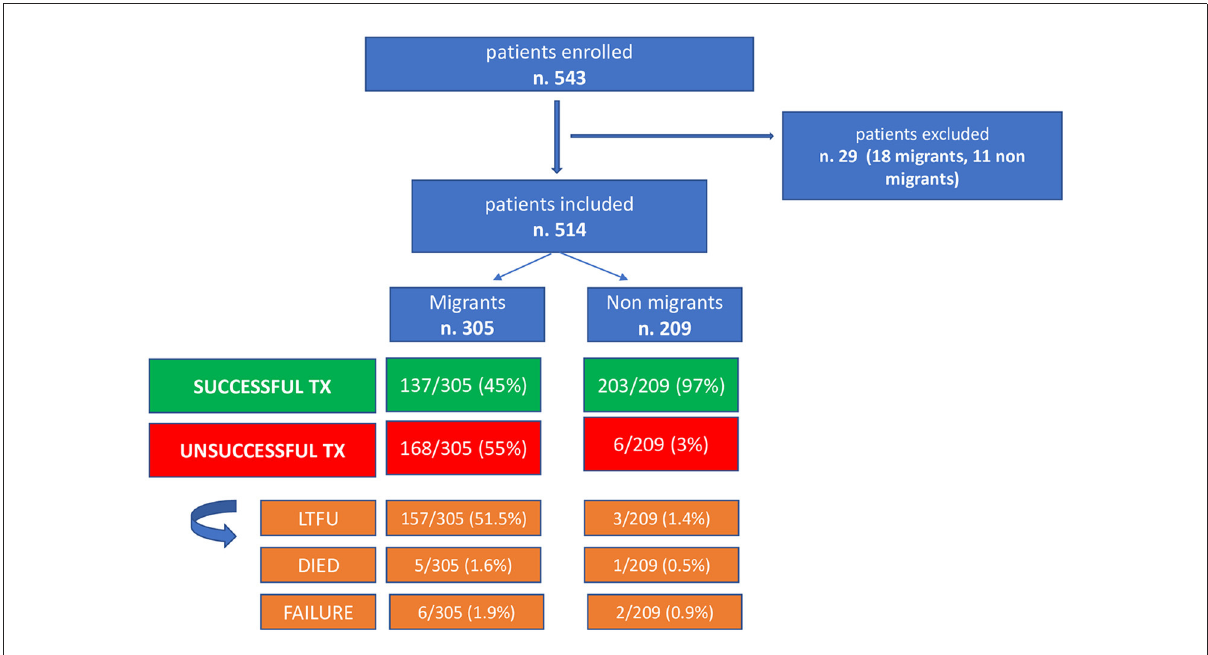
FIGURE1 Patients outcome enrolled in the